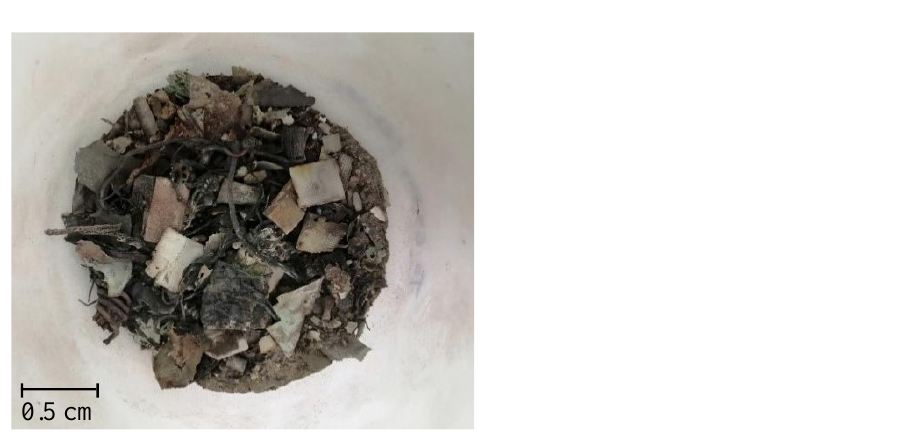
Figure 1. Solid WPCBs starting material.